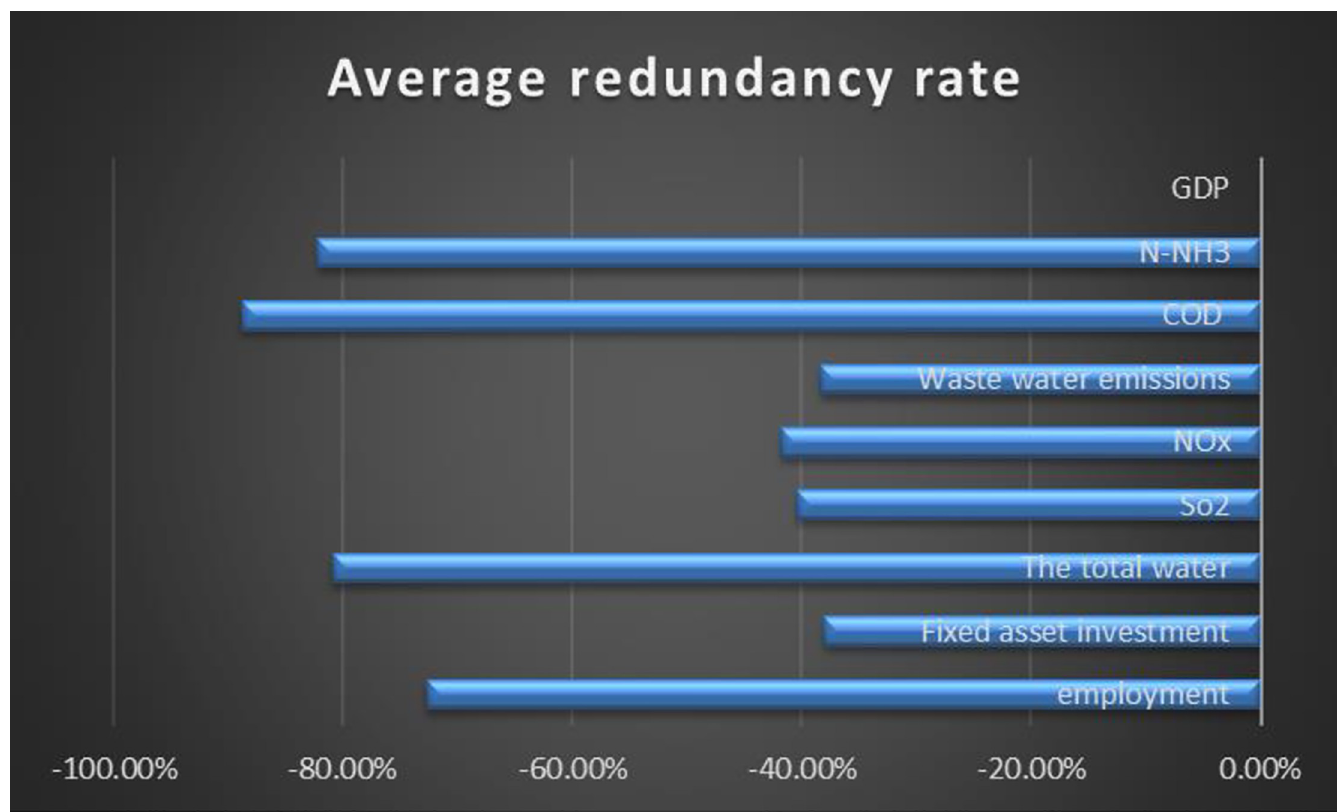
Fig 7. Comparison of redundancy rates of input and output